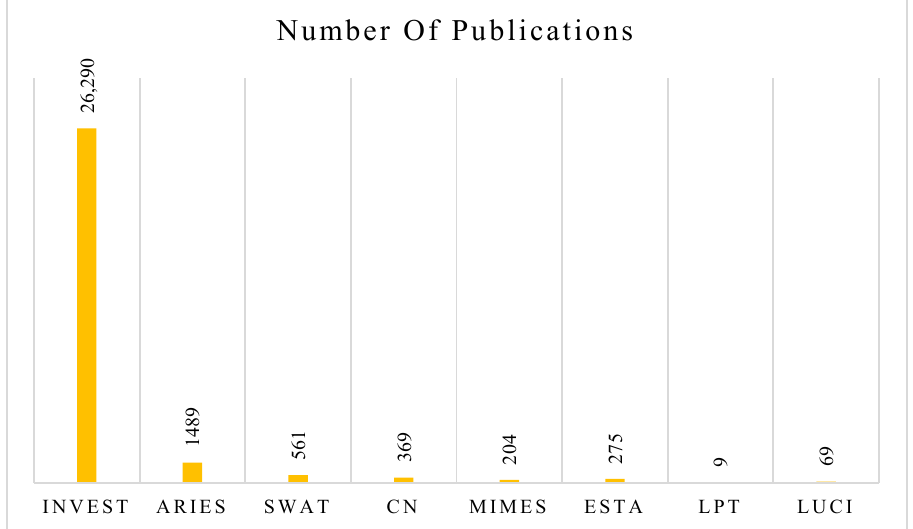
Figure 5. Number of publications on assessment models of ecosystem services.